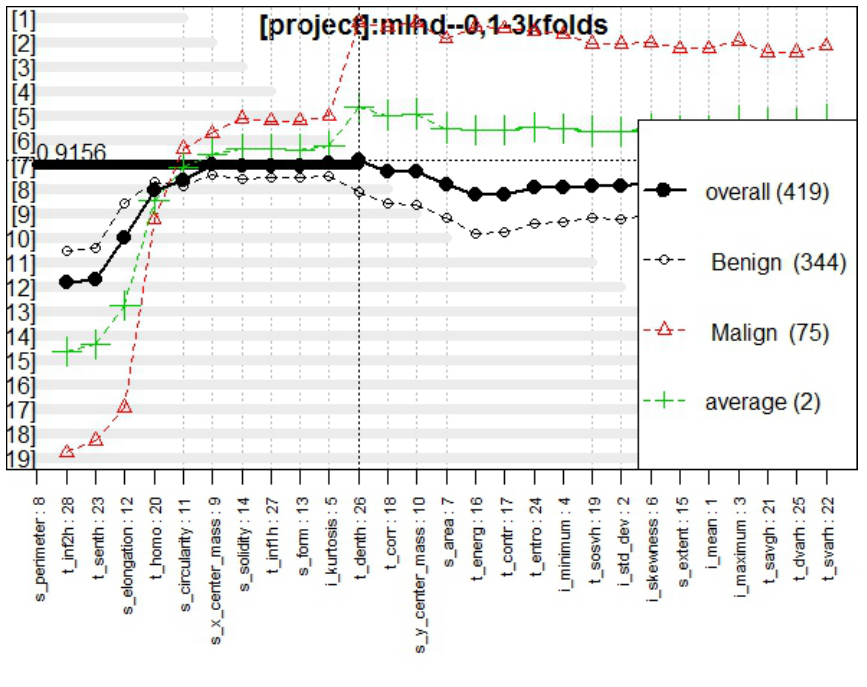
Figure 3. Genes behavior through Galgo algorithm with RF method.